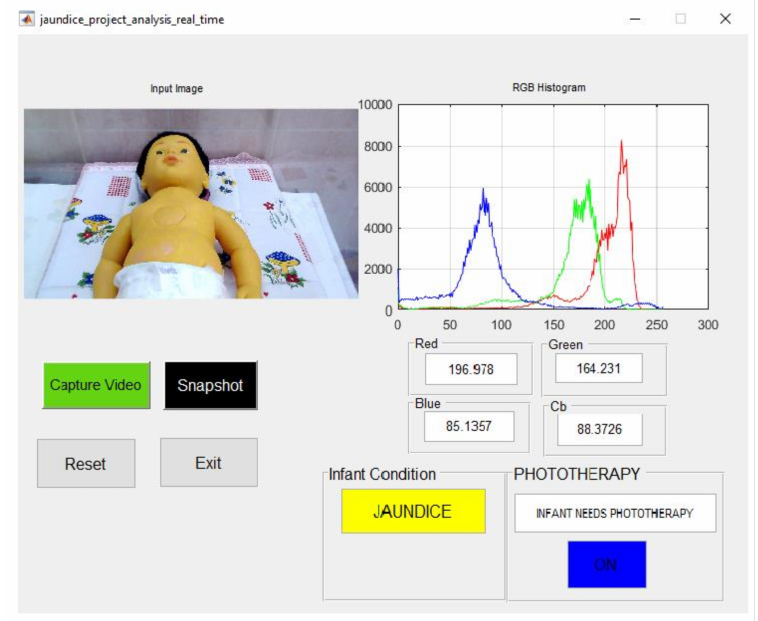
Figure 6. A manikin with a yellowish light skin color and